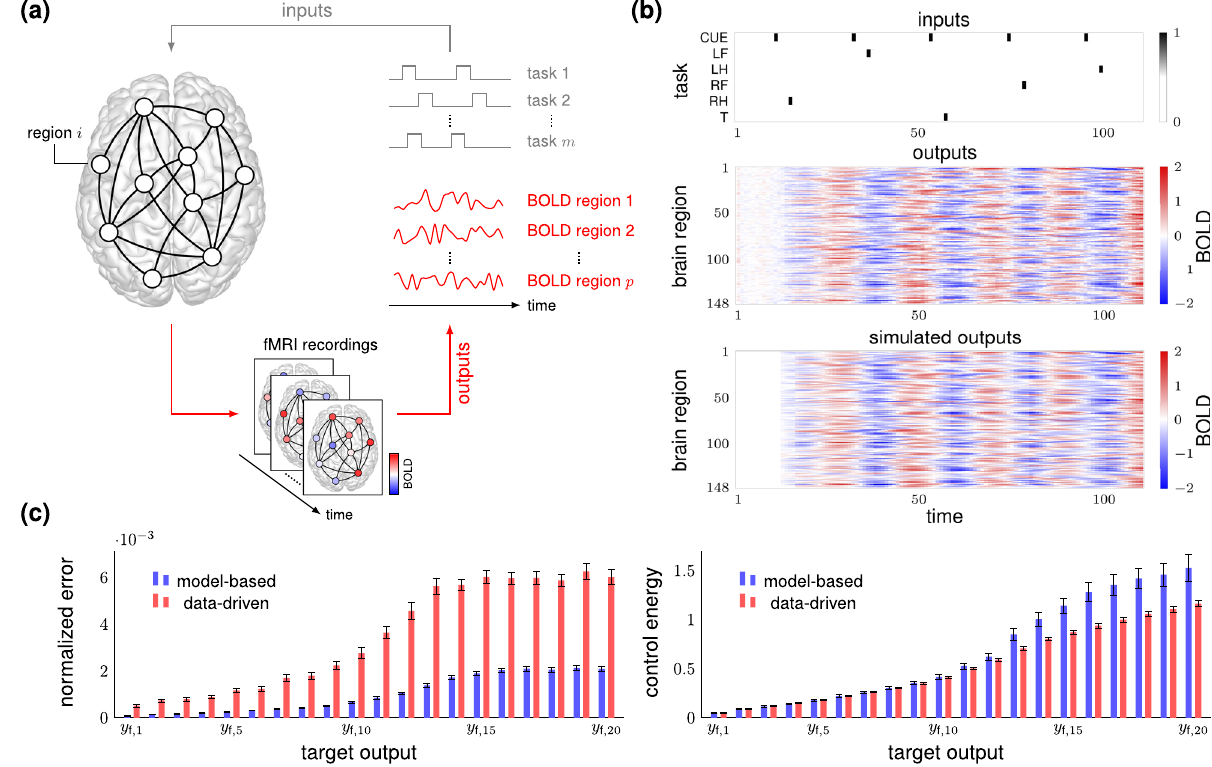
Fig. 6 Data-driven control of functional brain networks. Panel ( a ) provides a schematic of the experimental setup. A set of external stimuli represented by m different task commands induce brain activity. Functional magnetic resonance (fMRI) blood oxygen level-dependent (BOLD) signals are measured and recorded at different times and converted into p time series, one for each brain region. The top and center heatmaps of the panel ( b ) show the inputs and outputs, respectively, for the fi rst 110 measurements of one subject of the HCP dataset. The inputs are divided into m = 6 channels corresponding to different task conditions, i.e., CUE (a visual cue preceding the occurrence of other task conditions), LF (squeeze left toe), LH (tap left fi ngers), RF (squeeze right toe), RH (tap right fi nger), and T (move tongue). As in ref. 58 , each input is a binary 0 – 1 signal taking the value 1 when the corresponding task condition is issued and 0 otherwise. The outputs represent the BOLD signals of the p = 148 brain regions obtained from and enumerated according to the Destrieux 2009 atlas 59 . The bottom heatmap of the panel ( b ) displays the simulated outputs obtained by exciting the approximate low-dimensional linear model of ref. 58 with the input sequence of the top plot. In panel ( c ), we compare the performance of the data-driven and model-based strategy, assuming that the dynamics obey the above-mentioned approximate linear model. We set the control horizon to T = 100 and generate the data matrices by sliding a time window of size T across the data samples. The target state y f, i is the eigenvector associated with the i -th eigenvalue of the empirical Gramian matrix T ^ ^ ^ ^ W using the data-driven minimum-energy input in Eq. (5) and the C C T ¼ Y T U y 0 : T (cid:2) 1 . The left plot shows the error to reach the targets f y f ; i g 20 i C T , where T ¼ T ¼ 1 model-based one. The right plot shows the norm of the two inputs. The colored bars denote the mean over 100 unrelated subjects and the error bars are the 95% con fi dence intervals around the